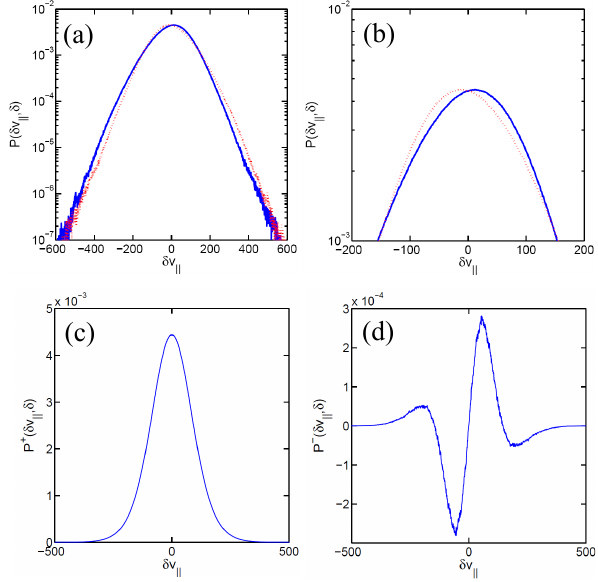
Fig. 1. PDF of δv || at δ = 64 1 , with 1 denoting the grid spac- ing, and δv || in the units of the bin size, see text. In (a) and (b) , P(δv || ,δ) in solid blue curve and P( − δv || ,δ) in dash red curve to show the asymmetry of the PDF with respect to δv || = 0. (b) is an enlarged version of (a) for a smaller range of δv || . The asymmetry is evident in (c) and (d) using P + and P decomposition of the PDF according to Eq. (1). In this and subsequent figures, the accuracy of the PDF is indicated by the noise level of the plot. For example, in this figure, in the region | δv || | < 300, the noise level is very small – not larger than the thickness of the curves. However, the PDF is approximatively (3.2 ± 0.4) 10 − 6 at δv || =